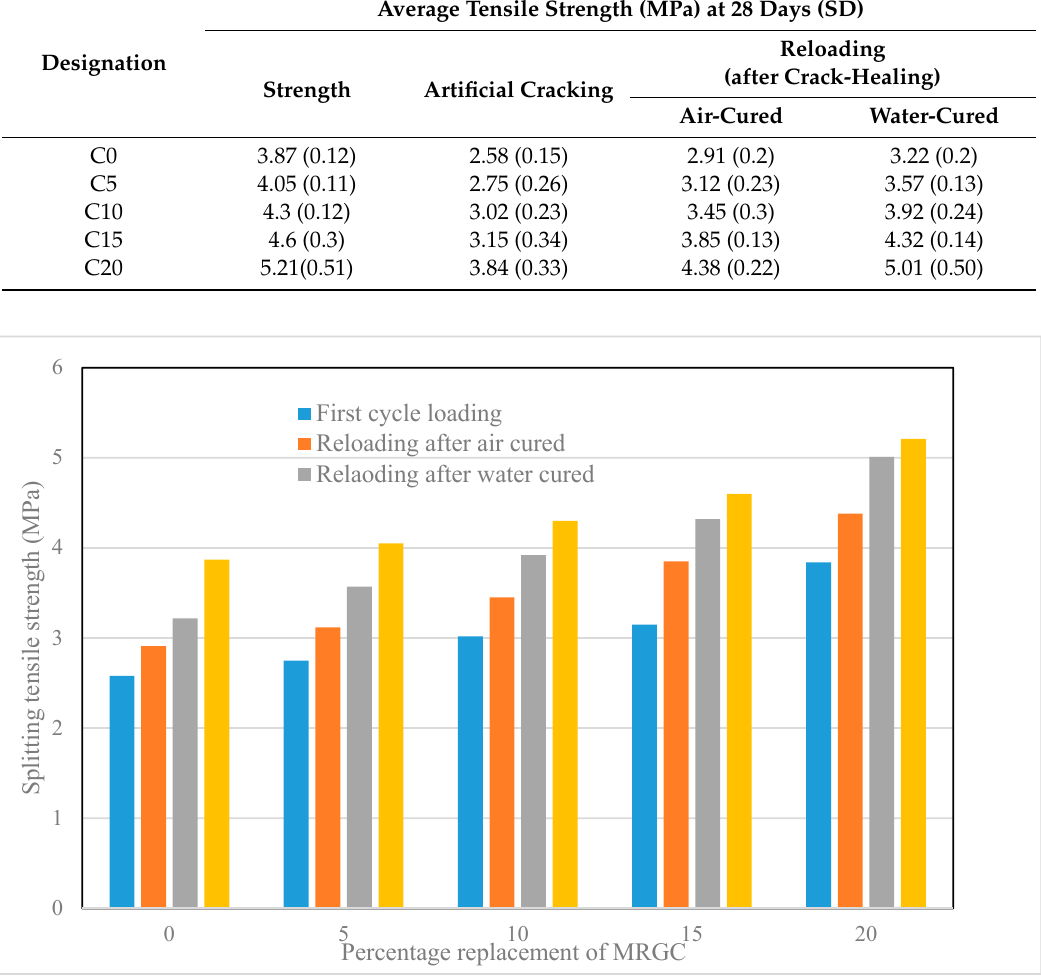
Figure 6. Splitting tensile strength regains due to the crack healing effect of MRGC.